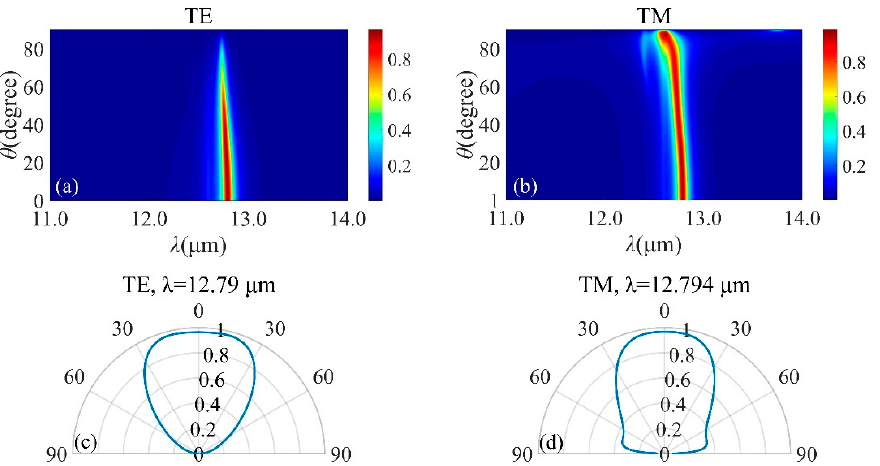
Figure 5. Emission spectra of SiC − based structure with 5 DBR pairs when t = 0.45 μ m, d s = 0.75 μ m, d 1 = 1.25 μ m and d 2 = 0.75 μ m for TE − ( a ) and TM − ( b ) polarization. Angle distribution of the emission with 5 DBR pairs with t = 0.45 μ m, d s = 0.75 μ m, d 1 = 1.25 μ m and d 2 = 0.75 μ m at λ = 12.79 μ m and λ = 12.794 μ m are illustrated for TE − ( c ) and TM − ( d ) polarizations, severally.